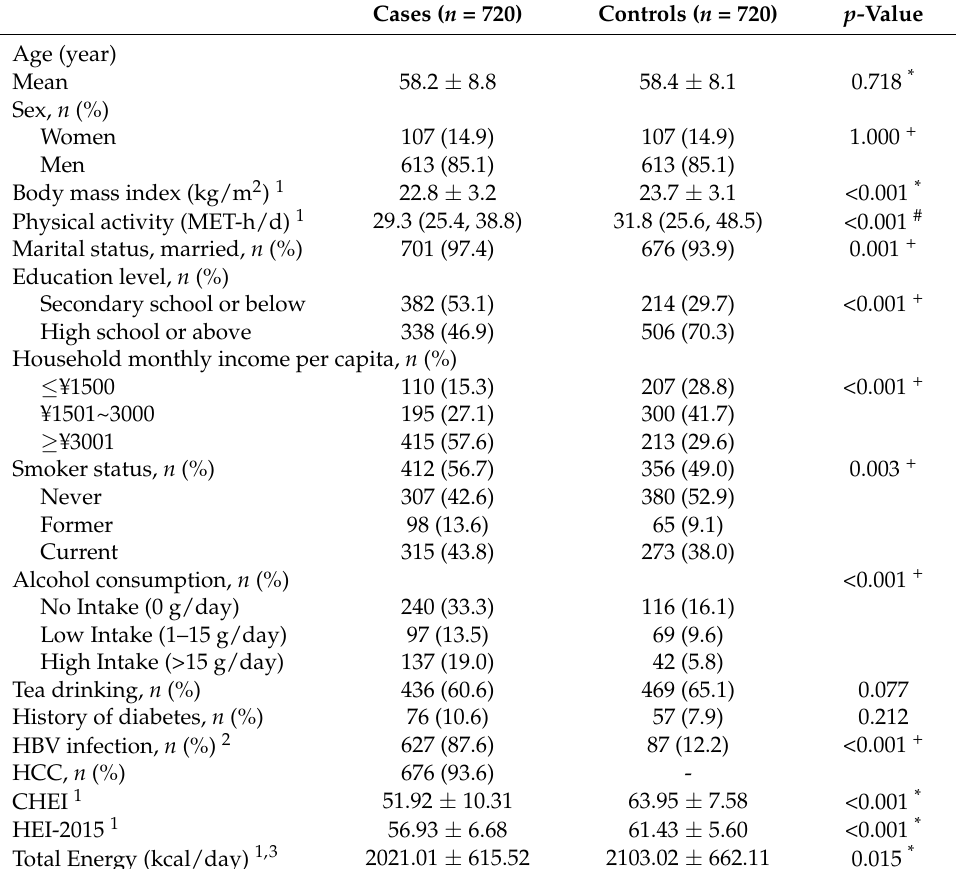
Table 1. Characteristics of cases of primary liver cancer and the corresponding controls. Cases ( n = 720) Controls ( n =